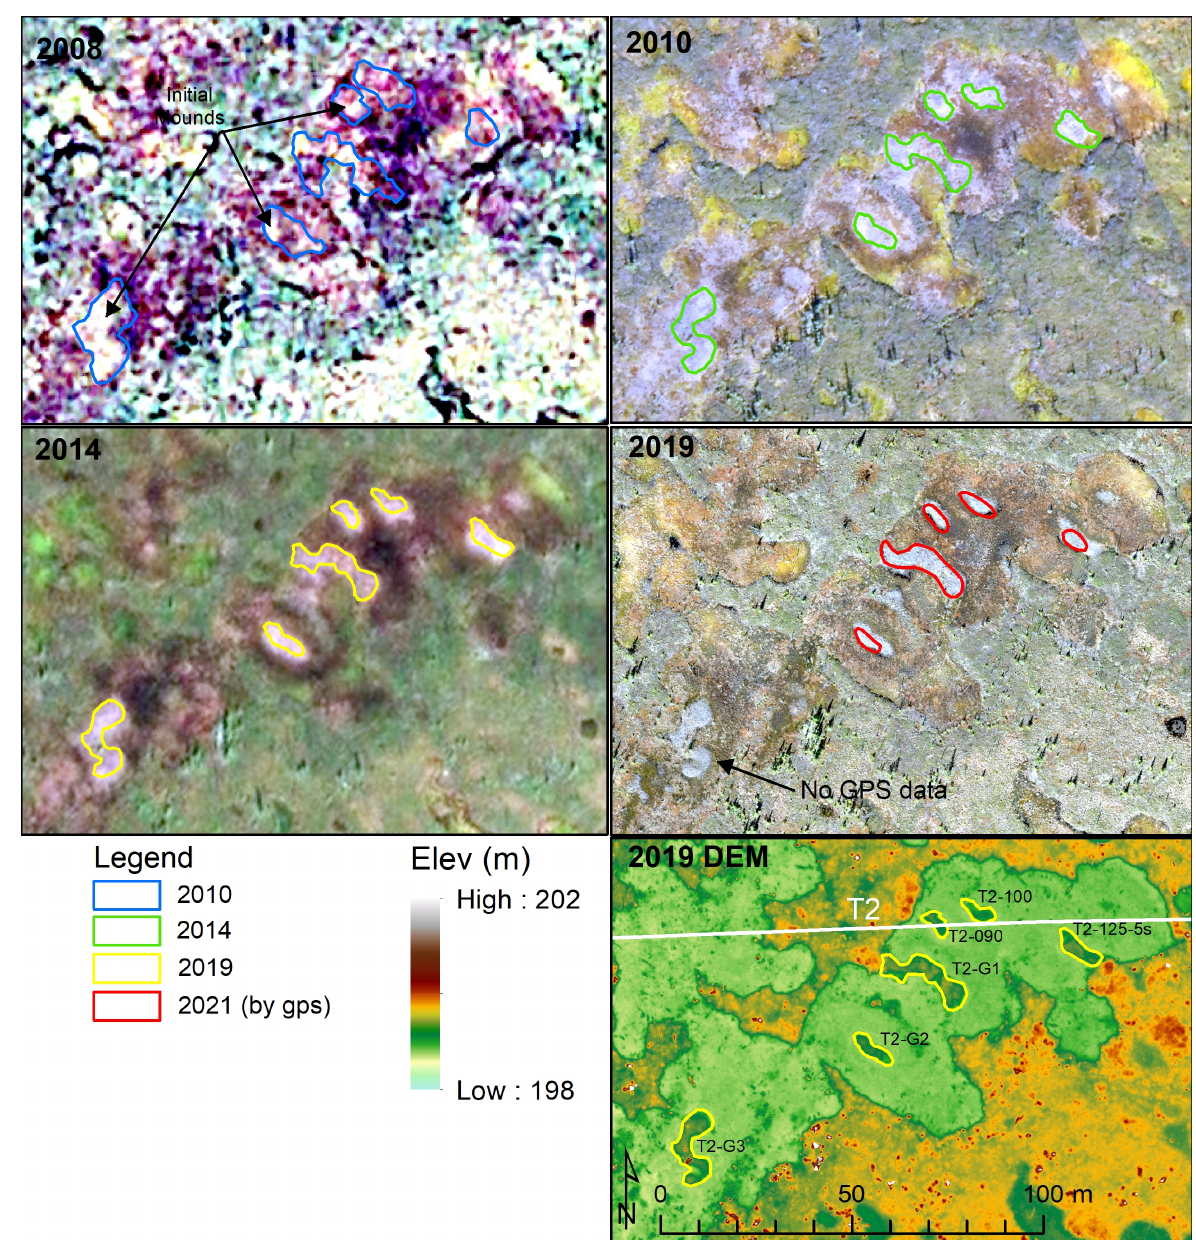
Figure 9. Time series of high-resolution imagery from 2008 to 2019, and a DEM from 2019, showing formation and degradation of permafrost mounds (palsas). The mounds reached maximum extent in 2010, while the 2014 and 2019 images, as well as 2021 field gps tracks show substantial degradation since formation. Extents of mounds are overlayed on the image of a previous year to show